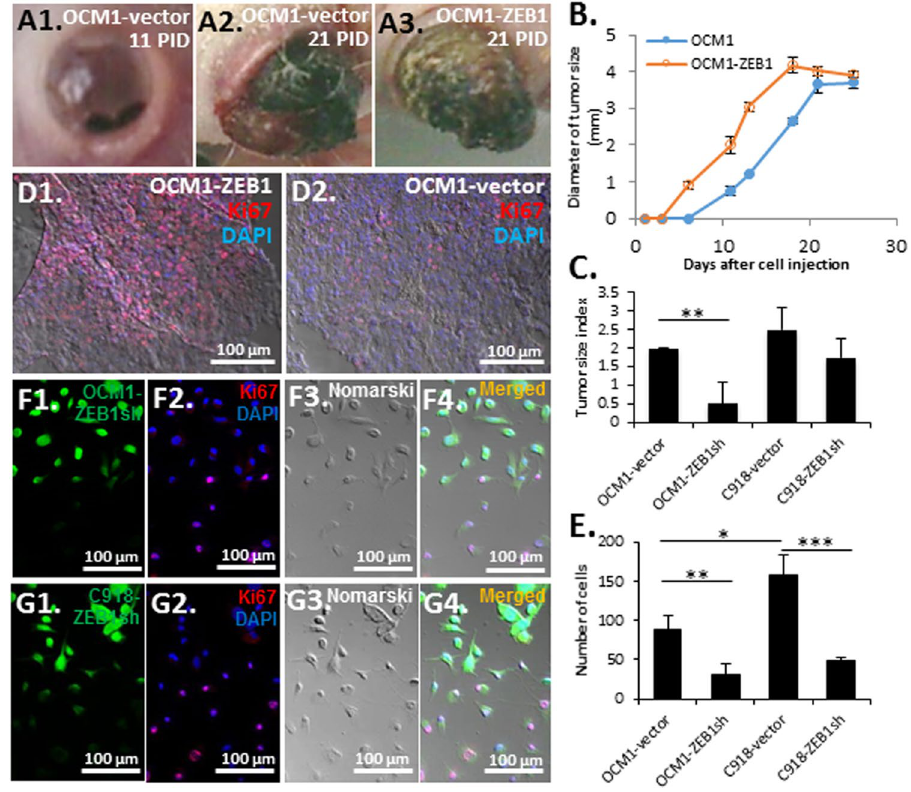
Figure 5. Effects of ZEB1 on tumor growth and cell proliferation. ( A ) Representative images showing tumor growth out of the eyes grafted with either OCM1-vector control or OCM1-ZEB1 cells at 11 and 21 post- inoculation day (PID). ( B ) OCM1-ZEB1 cell-derived tumors appeared 5 days earlier than OCM1 cell-derived tumors, but their growth rates and final tumor sizes were similar. ( C ) Equal number of cells (2 × 10 5 ) of both OCM1- and C918-vector controls and ZEB1sh knockdown cells were intravitreously injected into the nude mice and their 25-day grafted tumors were examined for tumor size evaluation. Based on the tumor H&E- stained sections, tumor size were subjectively classified into ‘No’, ‘Small’, ‘Medium’, and ‘Big’ categories and digitalized as 0, 1, 2, and 3, respectively. The pooled result of total 4 tumors was presented as a tumor size index for each injected cell line (Supplemental Table 5). ( D ) More mitotic cells were detected by Ki67 immunostaining in OCM1-ZEB1 cell-derived tumors than in OCM1-vector cell-derived tumors. ( E ) Equal number of cells (1 × 10 4 ) were seeded in a 10-cm culture plate. Cells in 5 randomly selected squares (5 × 5 mm 2 ) were counted. Both ( F ) OCM1-ZEB1sh and ( G ) C918-ZEB1sh cells were cultured on a chamber slide and immunostained with the mitotic marker Ki67 (red) before confluence. As knockdown levels of ZEB1 were consistent with the expression of EGFP (green), EGFP-dim thereby ZEB1 higher cells showed more Ki67 positive than those EGFP- bright thereby ZEB1 lower cells. Mean (M) ± standard deviation (SD). Student’s t-tests were performed. * indicates p ≤ 0.05; ** Indicates p ≤ 0.01; *** Indicates p ≤